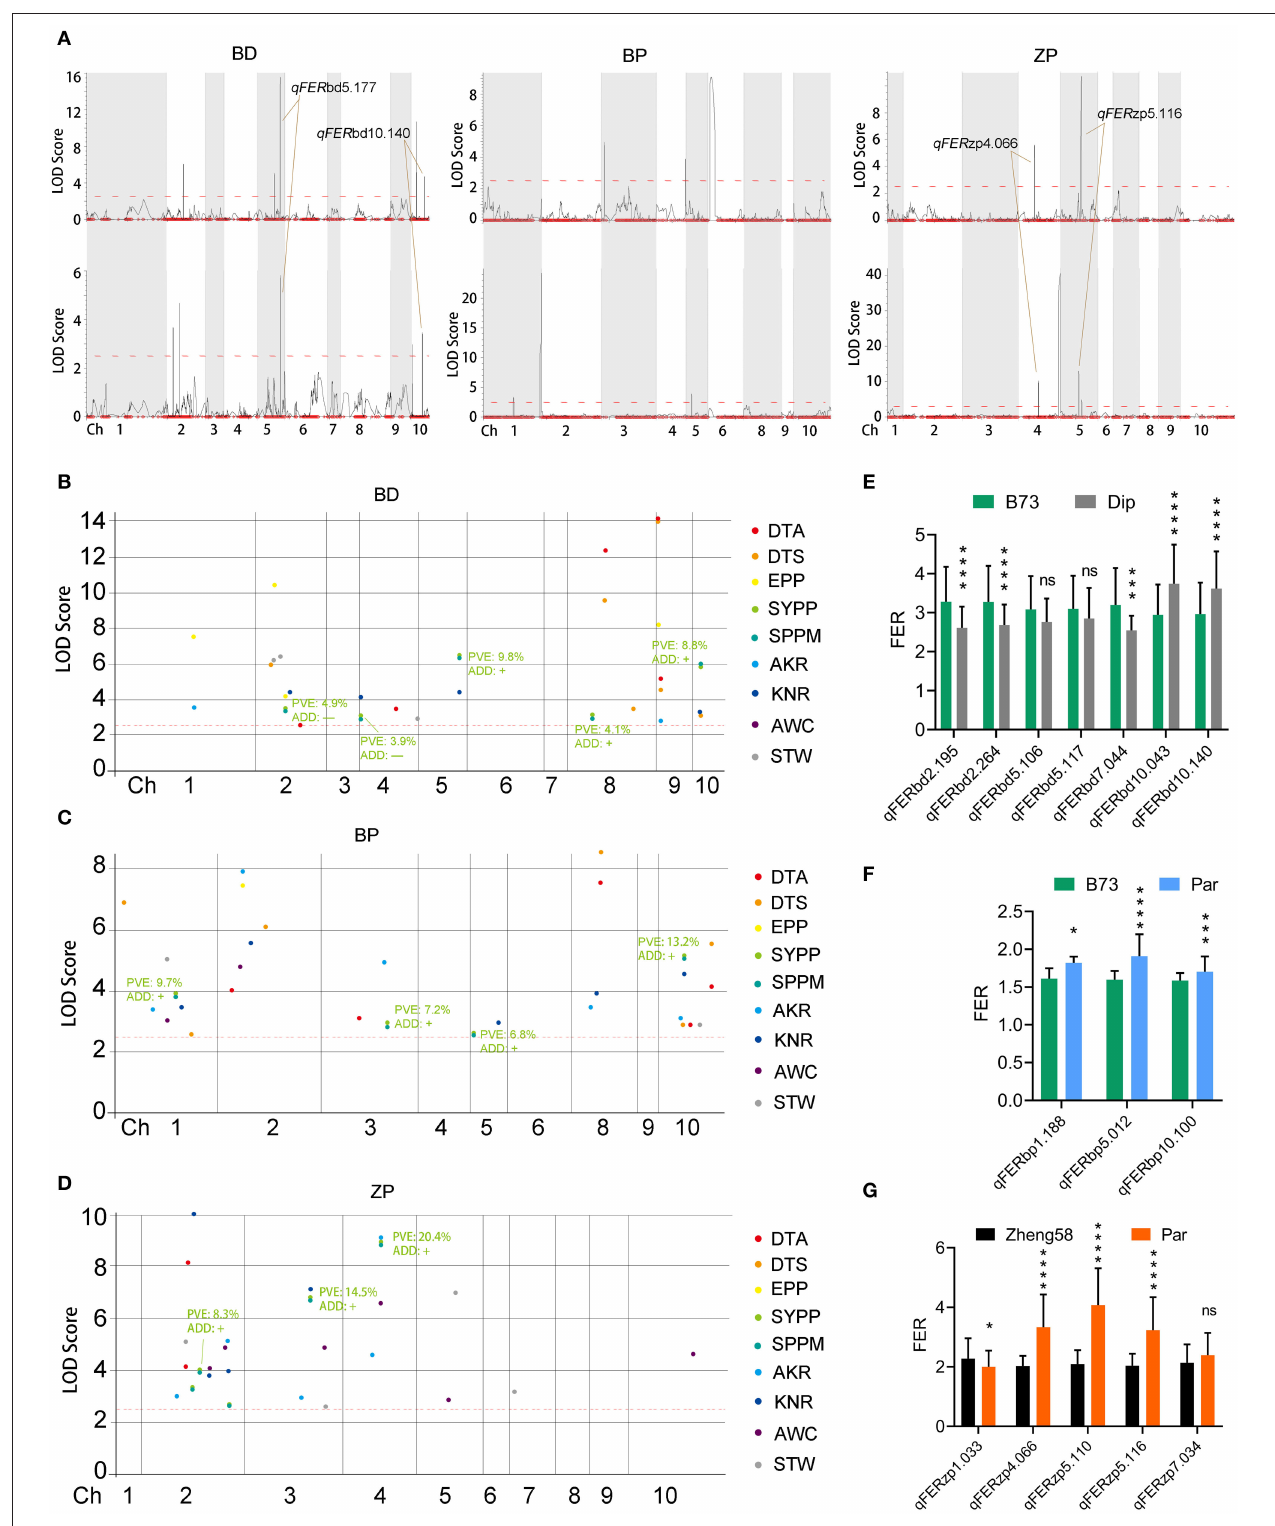
FIGURE 5 | Mapping for additive QTLs for FER and FER-correlated traits. (A) QTLs of FER in three populations from 2021 (the upper panel) and 2022 (the lower panel). (B–D) QTLs of nine FER-correlated traits in three populations. The BLUP values of each trait from 15 replicates in five environments were used for QTL mapping. The red dotted lines indicate the LOD threshold, and QTLs with higher LOD than this threshold are considered as candidate QTLs. DTA, day to anthesis;